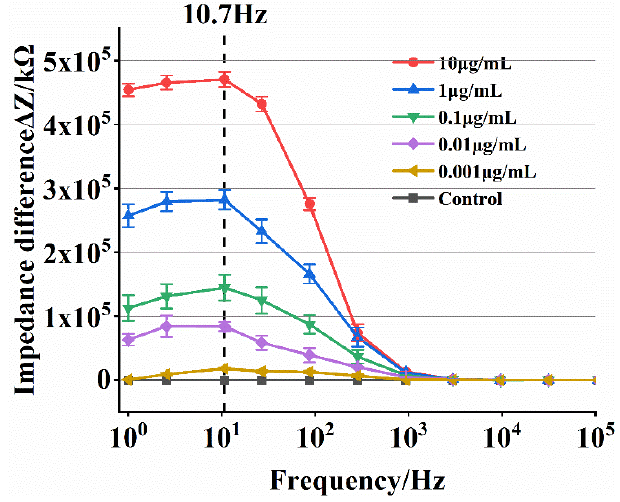
Figure 6. Impedance difference graph of different concentrations of virus.